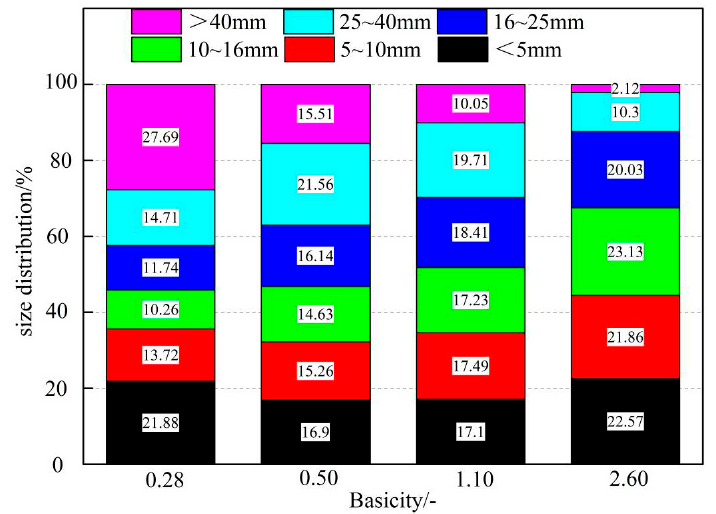
Figure 4. Size distribution of acid, self-fluxing, and high-basicity PVTM sinters.